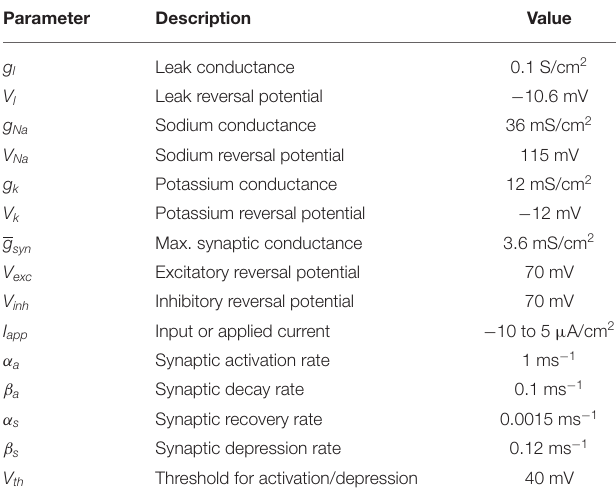
TABLE 1 | Parameters of the network model using Hodgkin-Huxley-type neurons.